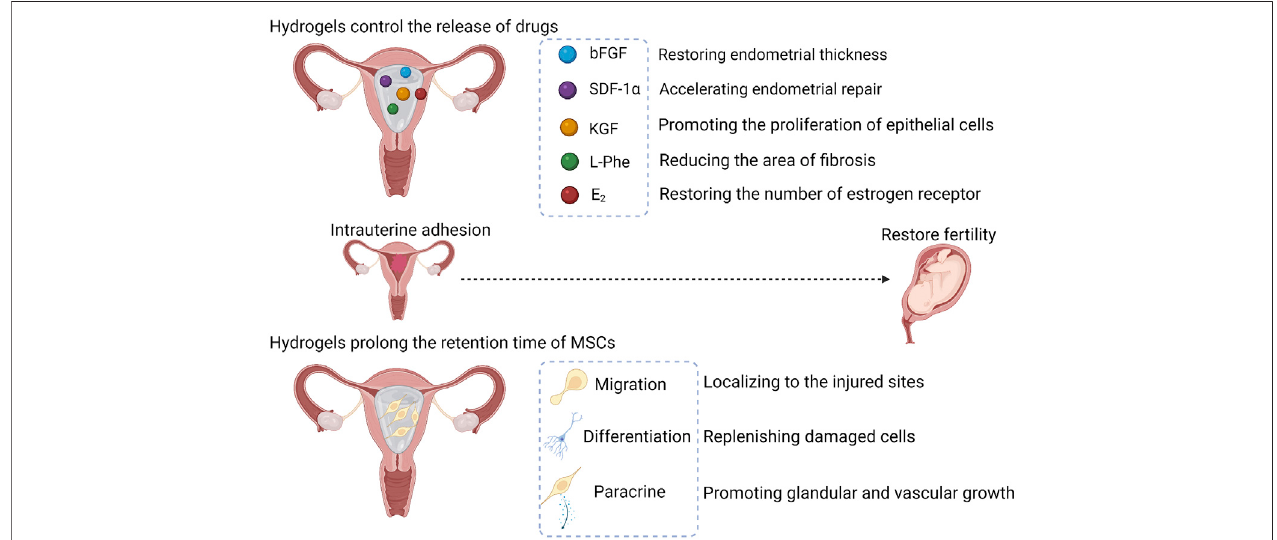
FIGURE 2 | The applications of hydrogels in IUA. The swollen hydrogels form a physical barrier to prevent adhesions. Hydrogels control the release of drugs in the uterine cavity, and drugs exert different therapeutic effects. Hydrogels prolong the retention time of MSCs in the uterus, giving MSCs the opportunity to exert its therapeutic effects. The therapeutic effects are dependent on migration, differentiation, and paracrine function of MSCs. MSCs, mesenchymal stem cells; bFGF, basic fi broblast growth factor; SDF-1 α , stromal cell-derived factor-1 α ; KGF, Keratinocyte growth factor; L-Phe, L -Phenylalanine; E